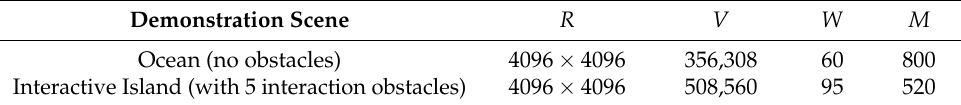
Table 5. Parameters used for phase and sea surface height